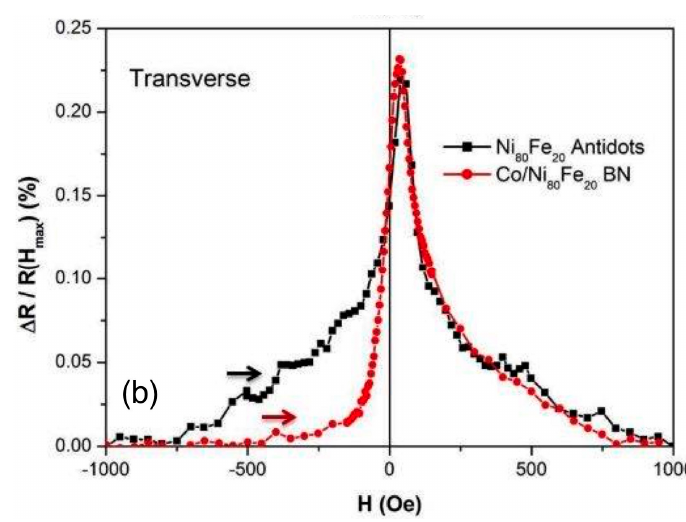
Figure 9. (Colour online) Room temperature magnetoresistance of Ni 80 Fe 20 antidot arrays and of bi-component nanostructured systems in longitudinal ( a ) and transverse ( b ) configuration. Arrows indicate the field span direction.